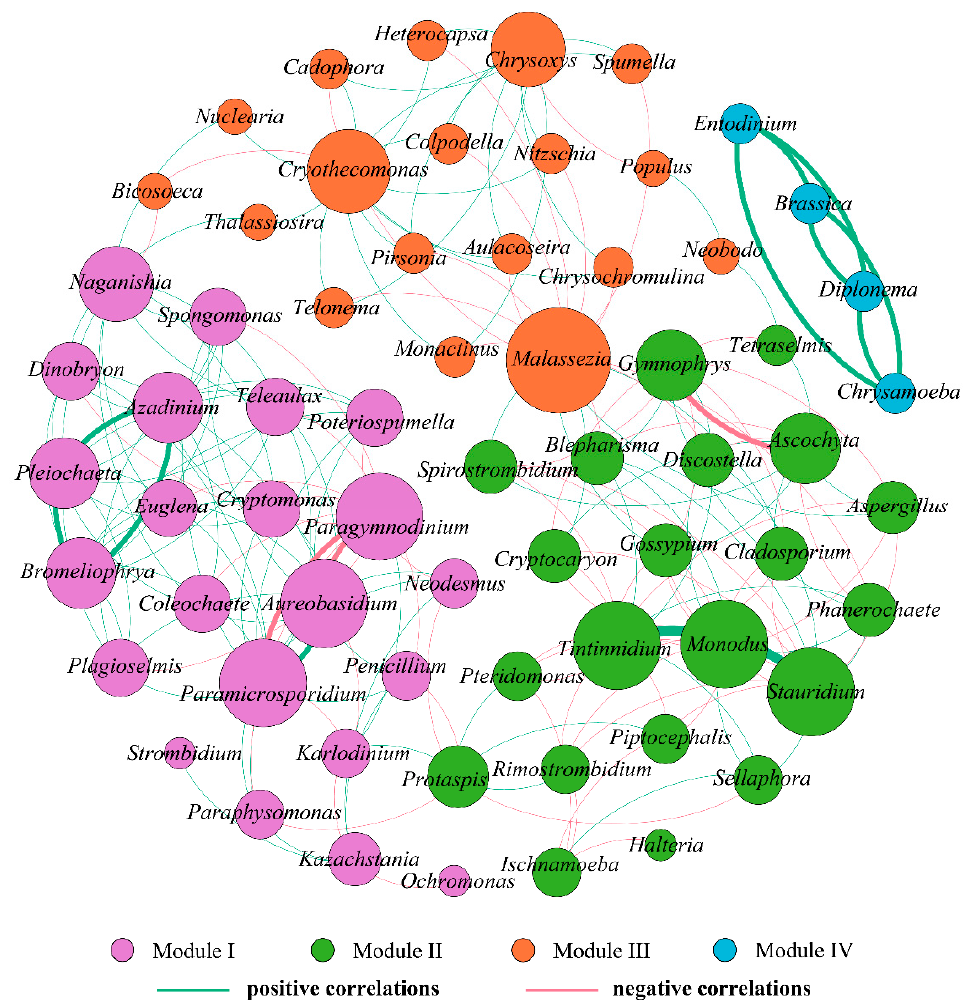
Figure 10. Coexistence and interaction of eukaryote community compositions at the genus level based on the 18S sRNA sequence and associated with water sample in December 2018. The nodes were colored according to modularity class. Each node represents one individual eukaryotic species. The larger the node is, the more connections it has to other nodes. The green line signifies a positive correlation, while the red line signifies a negative correlation.